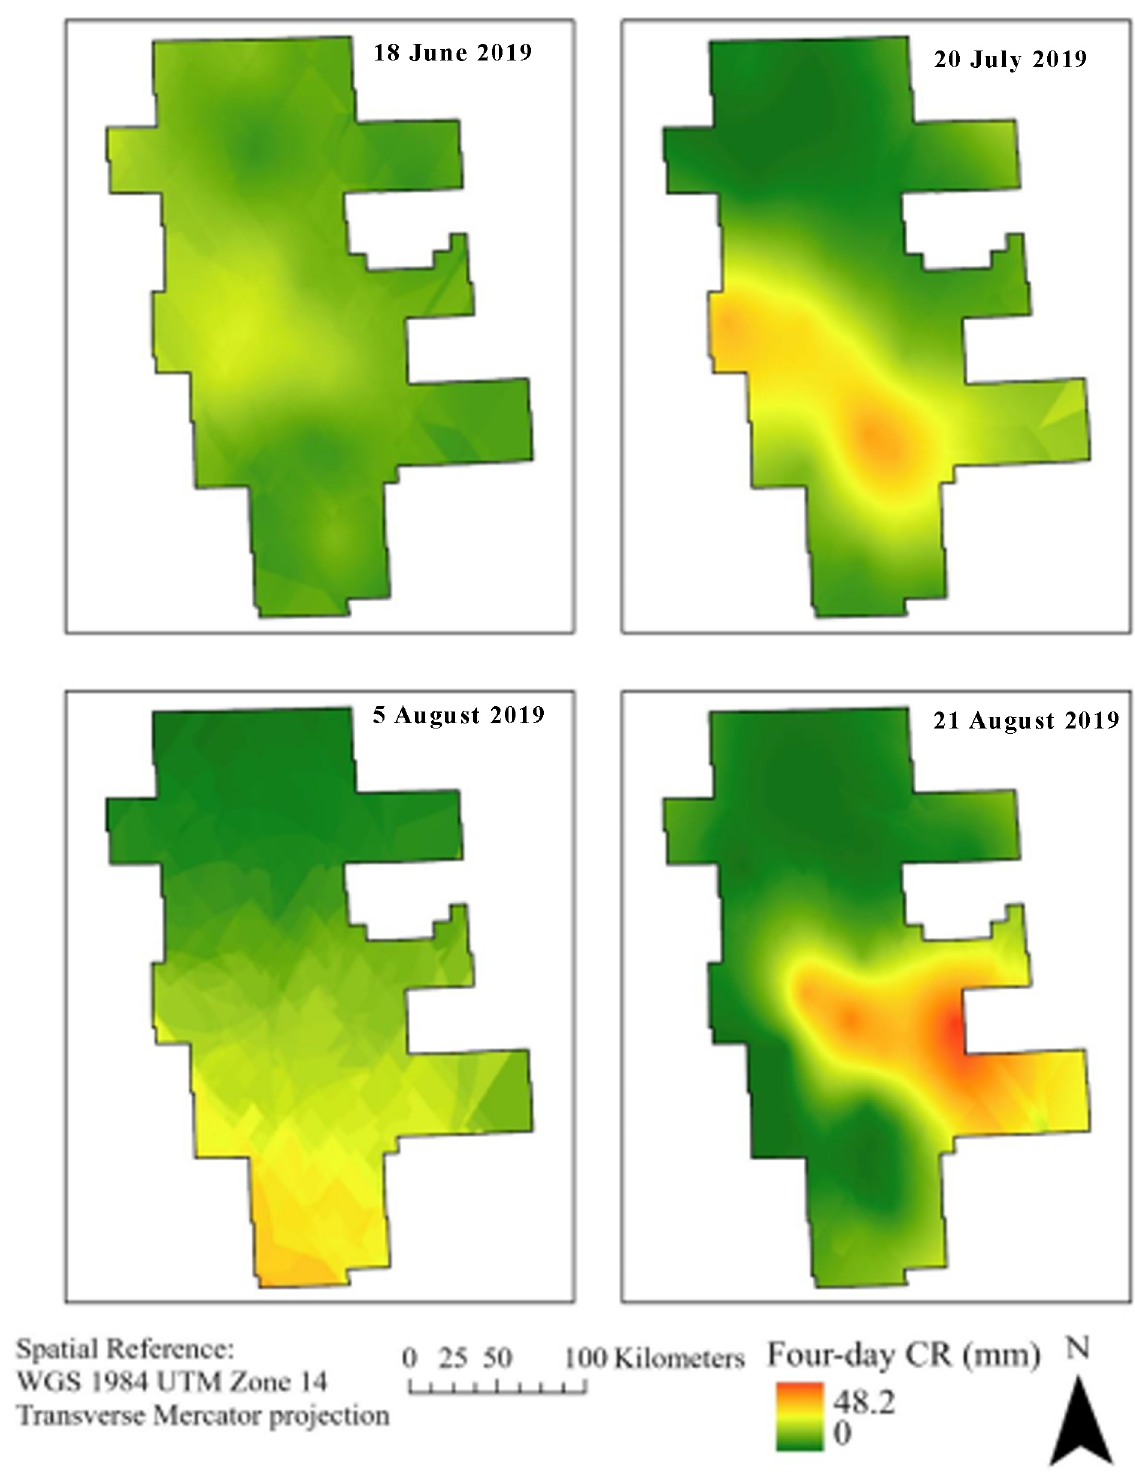
Figure 11. Four-days cumulative rainfall maps created using past four-days rainfall data from 25 weather stations by ordinary kriging interpolation in the RRVN for the 2019 growing season (18 June, 20 July, 5 August, and 21 August).